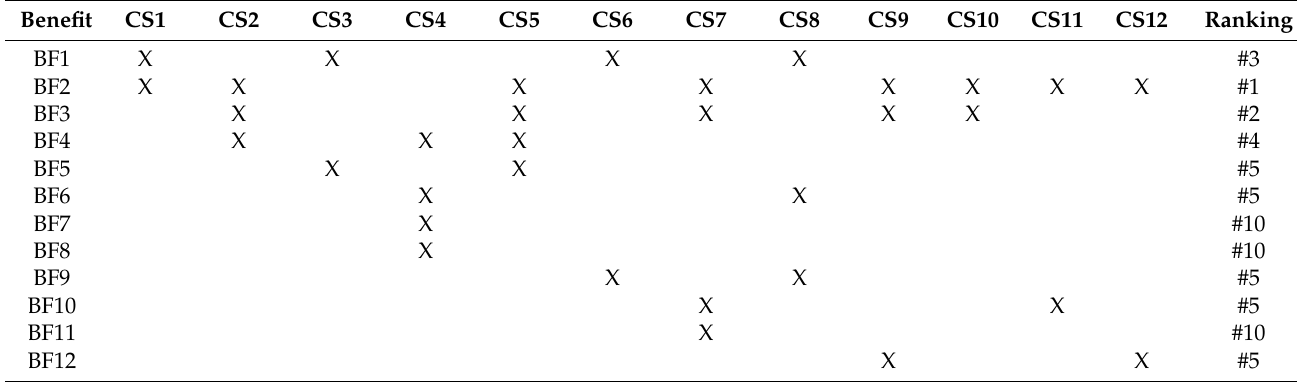
Table 4. Comparative analysis of benefits and